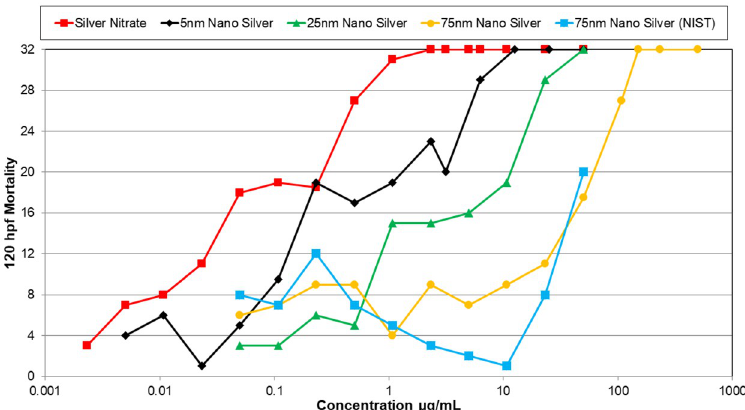
Fig 2. Mortality curves of zebrafish embryos exposed to different nanomaterials. 120 hpf mortality curves of zebrafish embryos exposed to different nanomaterials. Mortality curves consist of multiple tests. If the concentrations between tests of the same nanomaterial overlapped, the average mortality at the concentration was reported in the mortality curve. This figure shows the mortality curve of silver nanomaterials based on size without the concentrations being adjusted for the ionic concentration of silver in solution. (120 hpf (LC50) for the silver nanomaterials are as followed: silver nitrate (0.08 μ g/mL), 5 nm nano silver (0.71 μ g/mL), 25 nm nano silver (3.68 μ g/mL), 75 nm nano silver (33.1 μ g/mL), and 75 nm nano silver (NIST) (43.3 μ g/mL)).